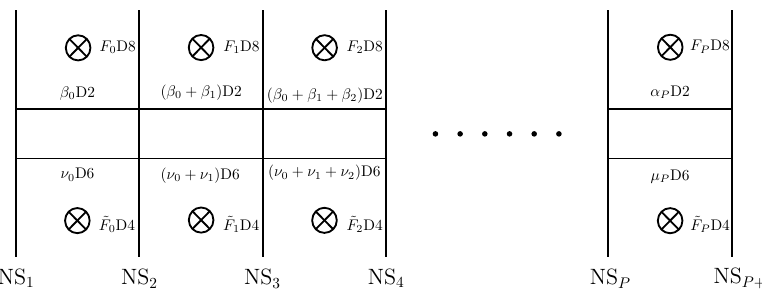
Figure 4 . Hanany-Witten set-up associated with our generic quiver in (cid:12)gure 3. The vertical lines denote NS (cid:12)ve branes, horizontal lines D2 and D6 colour branes. The crosses, D4 and D8 (cid:13)avour